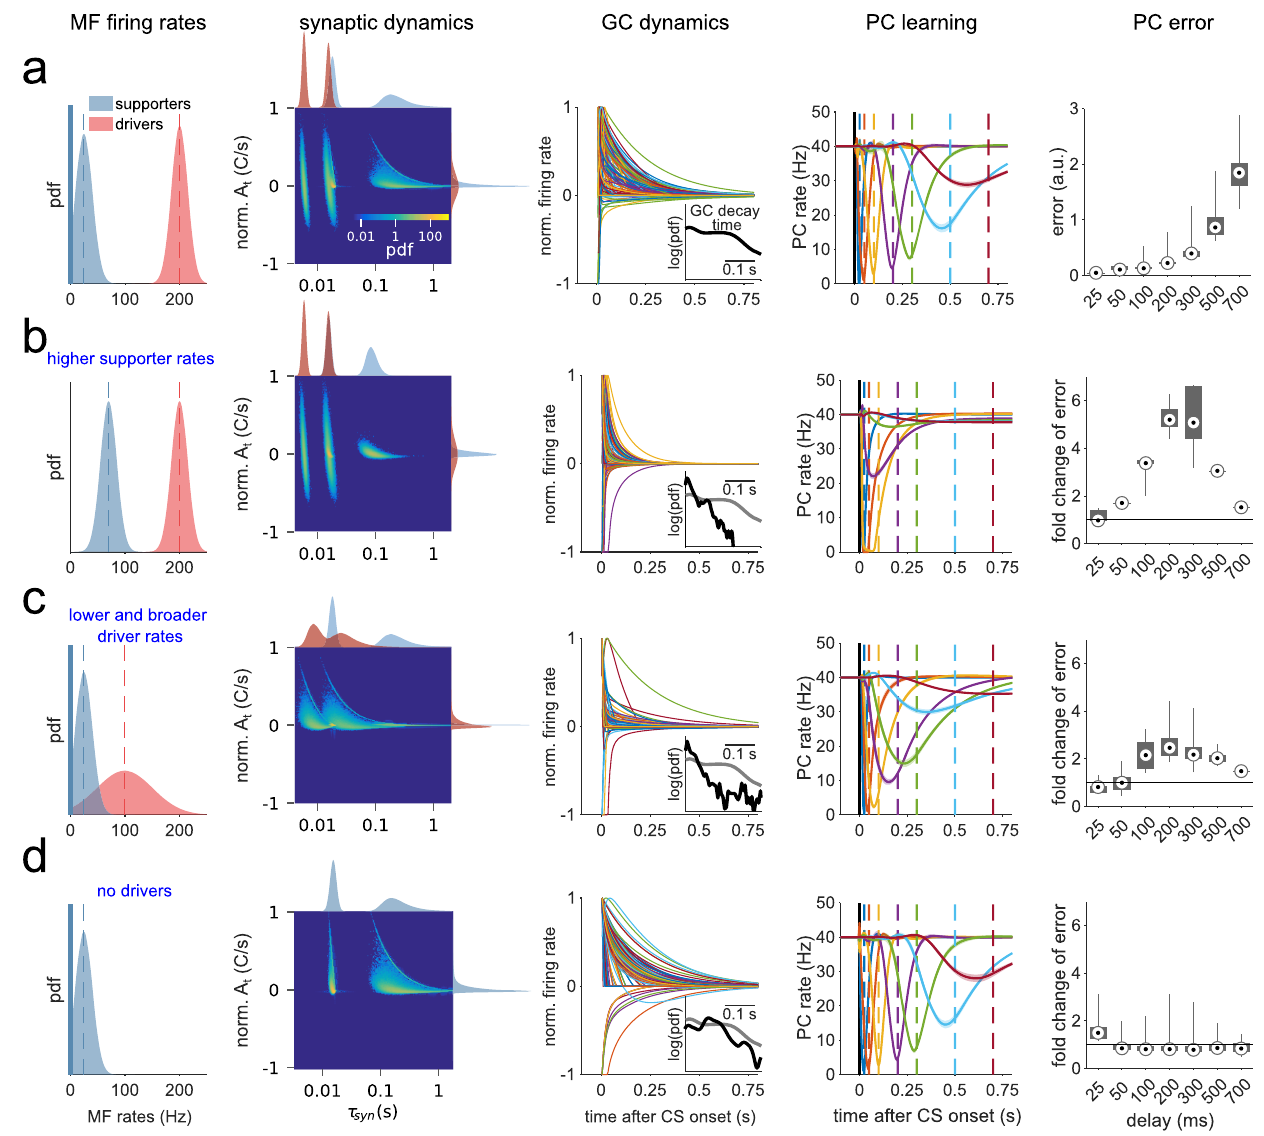
Fig. 4 | Learning performance depends on MF fi ring rate distributions. a First panel:DriverandsupporterMF fi ringratepdfs( μ D =200Hz, μ S =25Hz, σ D = σ S =15 Hz). Second panel: Resulting joint A t and τ syn distribution, featuring four partially overlapping clusters, corresponding to the slow and fast pools for driver and supporter synapses, and marginal distributions. The color code of the joint dis- tribution scales logarithmically. Colors of marginal distributions indicate driver (red) and supporter (blue) components. Third panel: Normalized GC transient responsestoCS.Inset:pdfofthedistributionofdecaytimesto10%ofthetransient peak. Fourth panel: learned PC pauses, averaged over n = 20 simulations with different realizations of MF patterns and MF-GC connectivity. Dashed lines mark